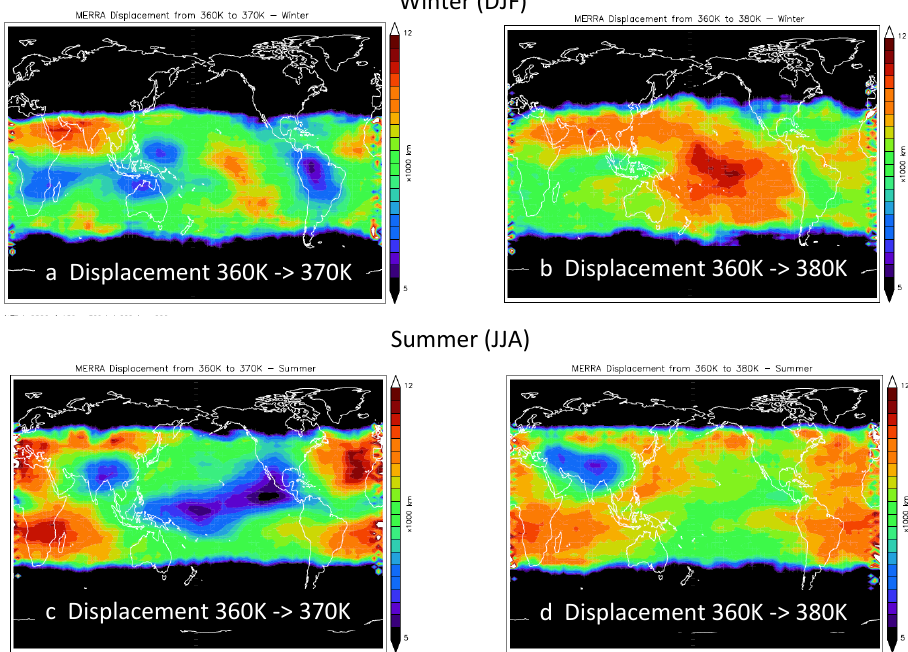
Fig. 3. The average displacement for parcels originating at ∼ 360K reaching the 370K and 380K levels. (a) , DJF for 360 to 370K; part (b) DJF for 360 to 380K; part (c) JJA for 360 to 370K, and (d) JJA for 360 to 380K. Displacement distances range from 5 to 12 thousandkm.